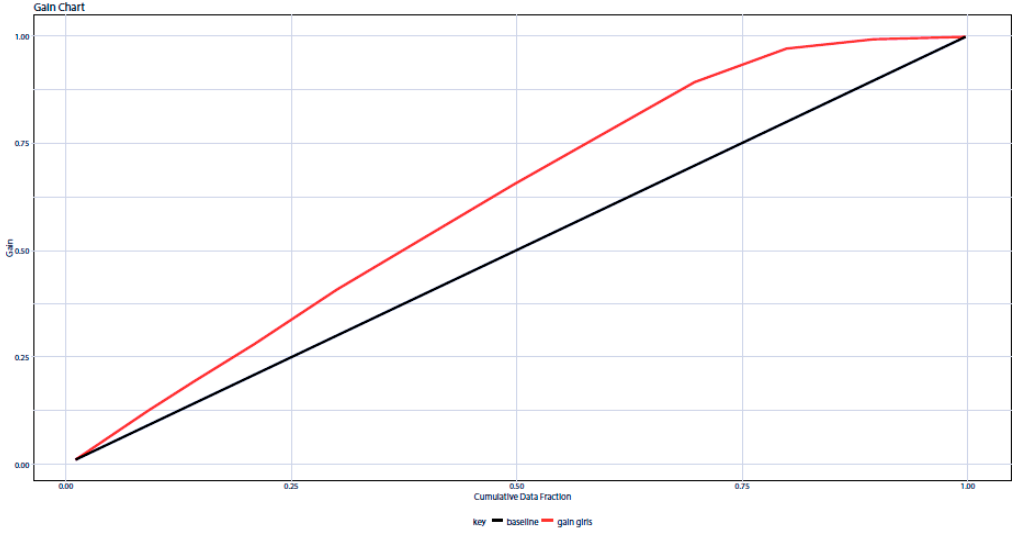
Figure 7. Gain chart for the female students’ sub-sample. Mathematics 2020 , 8 , x FOR PEER REVIEW